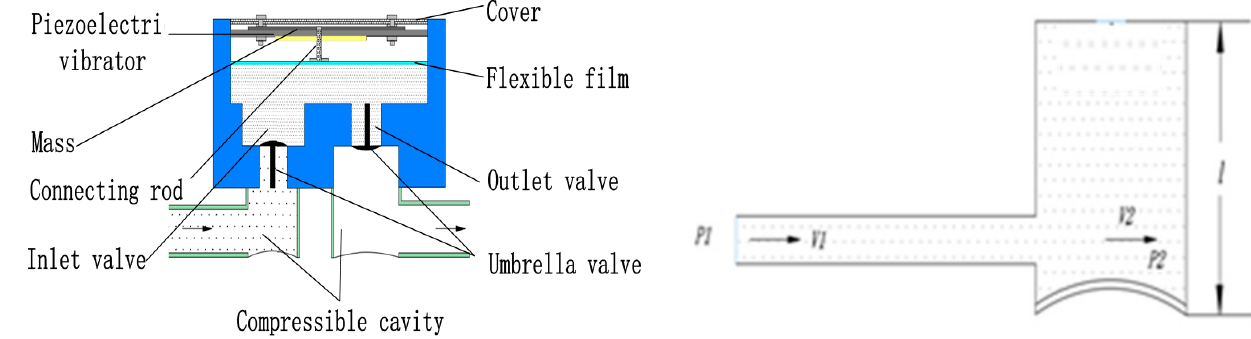
Figure 1. Schematic diagram of fluid flow in the compression chamber.